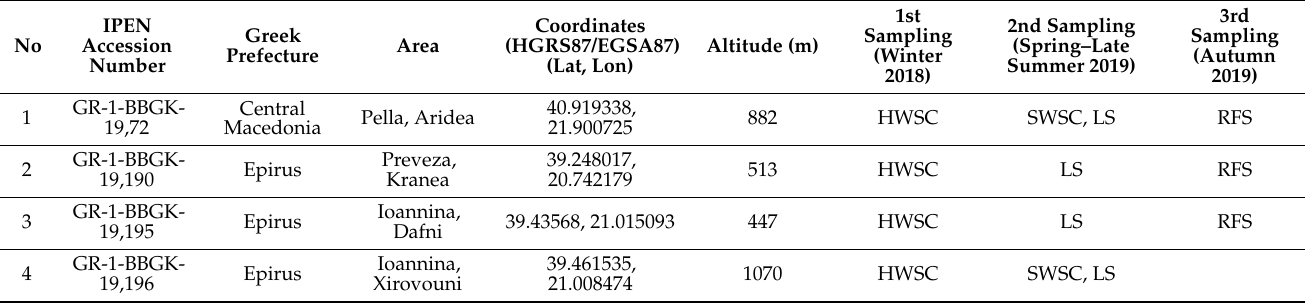
Table 5. IPEN accession number, location, altitude, and sampling details of the genotypes (population samples) of Greek native Cornus mas germplasm collected from various areas and habitats of Northern Greece in